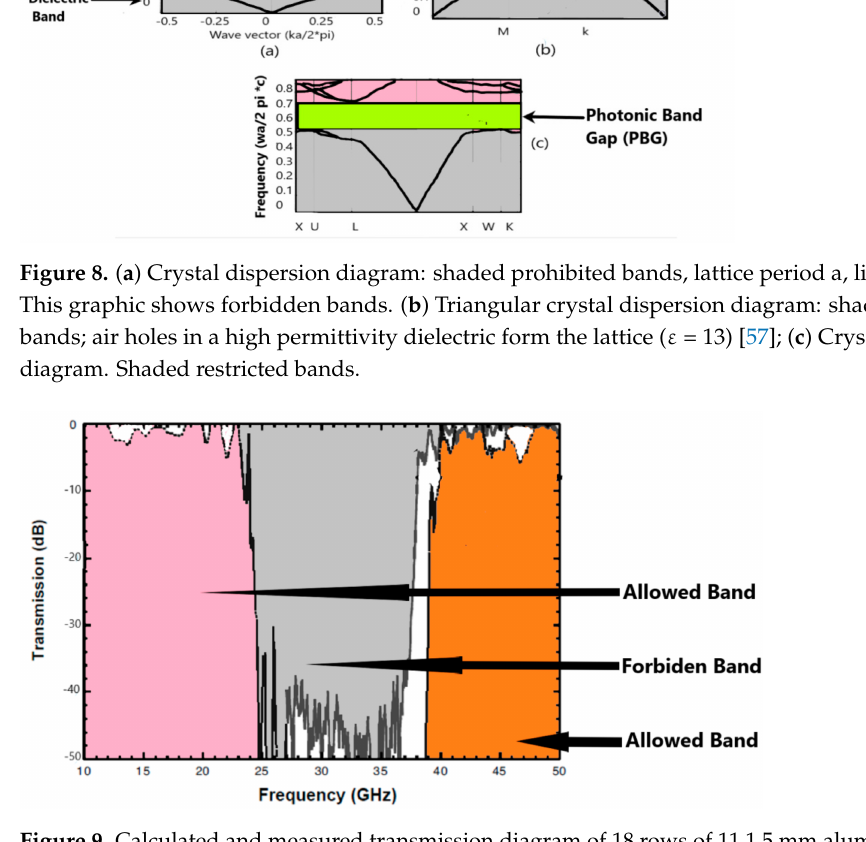
Figure 9. Calculated and measured transmission diagram of 18 rows of 11 1.5 mm alumina rods with a 3 mm period (transverse magnetic polarization: electric field E is parallel to rod axis)